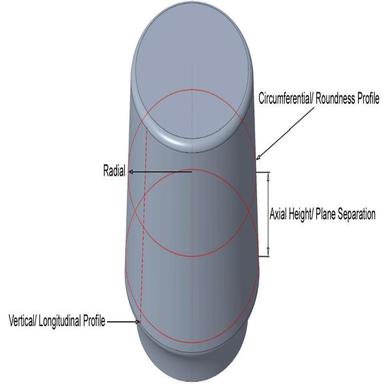
Diagram outlining terminology in relation to the measurement of taper geometry.